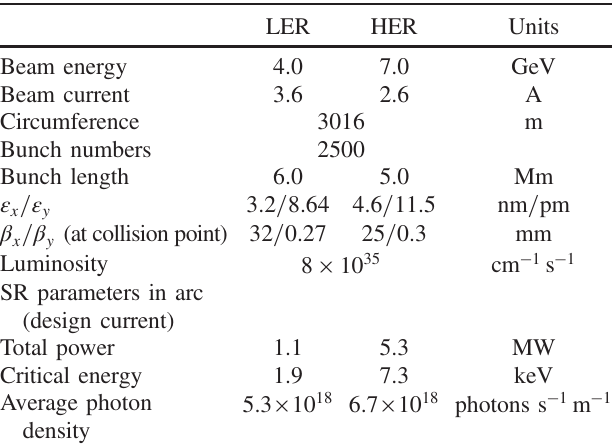
TABLE I. Main design parameters of the SuperKEKB MR.